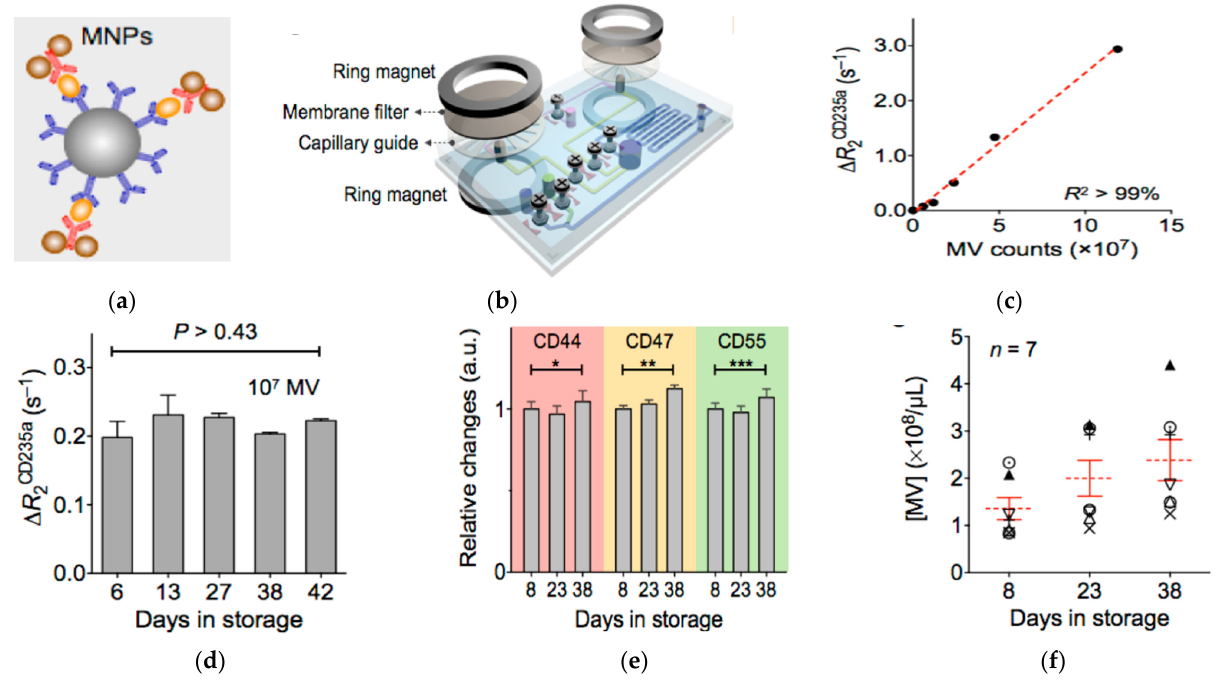
Figure 6. Magnetic nanosensor for the detection and profiling of microvesicles derived from red blood cells (RBC). ( a ) Schematic of microvesicle labeling with MNPs. ( b ) Schematic of the µ NMR system showing the derived sensor coupled with membrane filter for microvesicle separation. ( c ) Relaxation rate change ( ∆ R 2 CD235a) versus the number of microvesicles using CD235a targeted MNPs. ( d ) ∆ R 2 CD235a at different days of red blood cell storage showing stable vesicle expression of CD235a. ( e ) Relative changes in the expression levels of CD44, CD47, and CD55 during storage of red blood cells showing little changes in the expression levels of these proteins on microvesicles. * p > 0.48; ** p > 0.15; *** p > 0.17. ( f ) Microvesicle concentration over storage time showing the increase of the amount of microvesicles with storage time. Reprinted with permission from